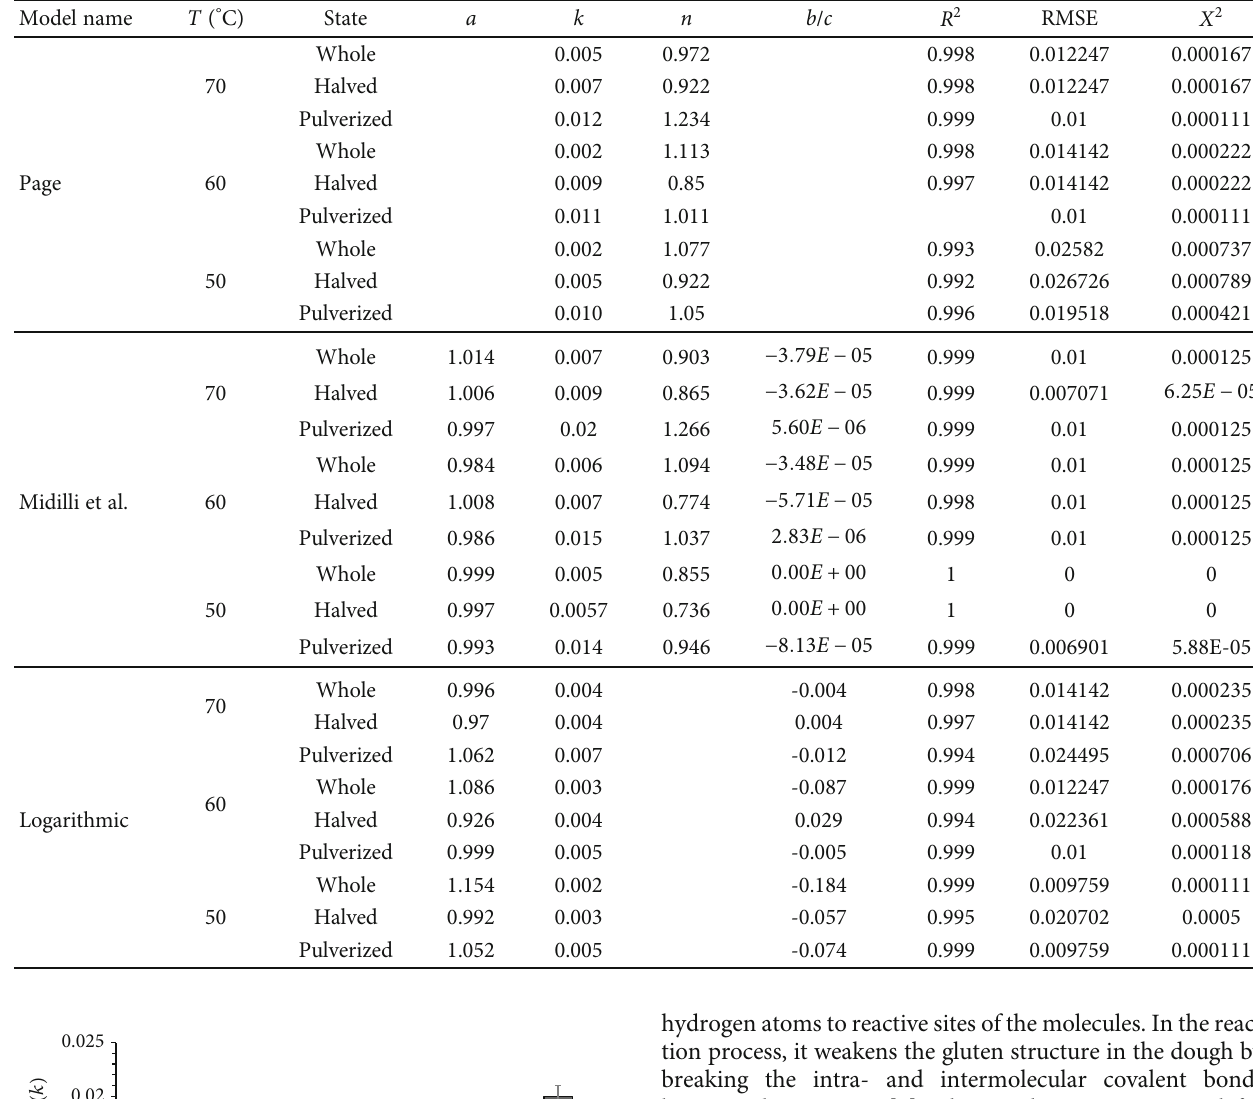
Table 2: Results of fi tting the experimental data for tiger nuts and their estimated constants for the various air temperatures. Model name